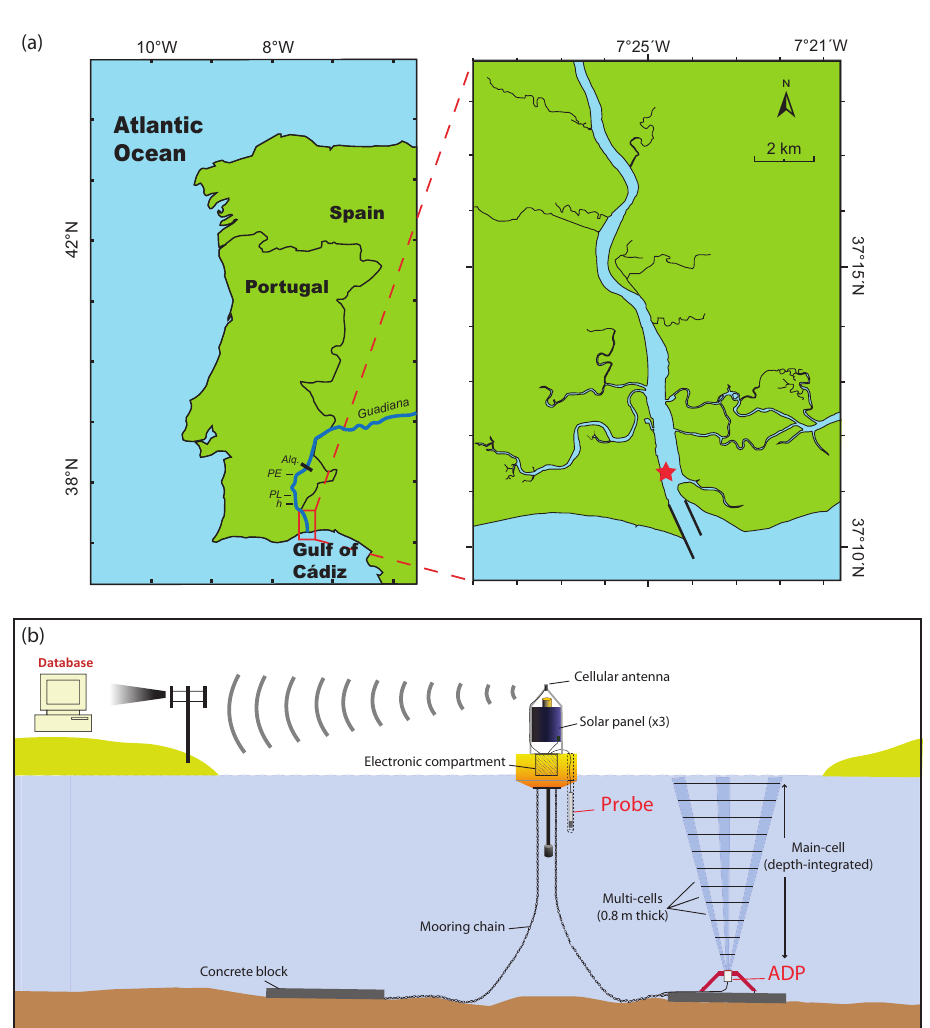
Figure 1. Location (a) and description (b) of the SIMPATICO monitoring system. The system (a) is located near the mouth of the Guadiana Estuary on the southern Iberian Peninsula (red star). The locations of the Alqueva dam (Alq.), estuary head ( h ), Pedrogão (PE) and Pulo do Lobo (PL) hydrographic stations are indicated. The equipment of the station (b) includes a multi-parametric probe and an acoustic Doppler current profiler